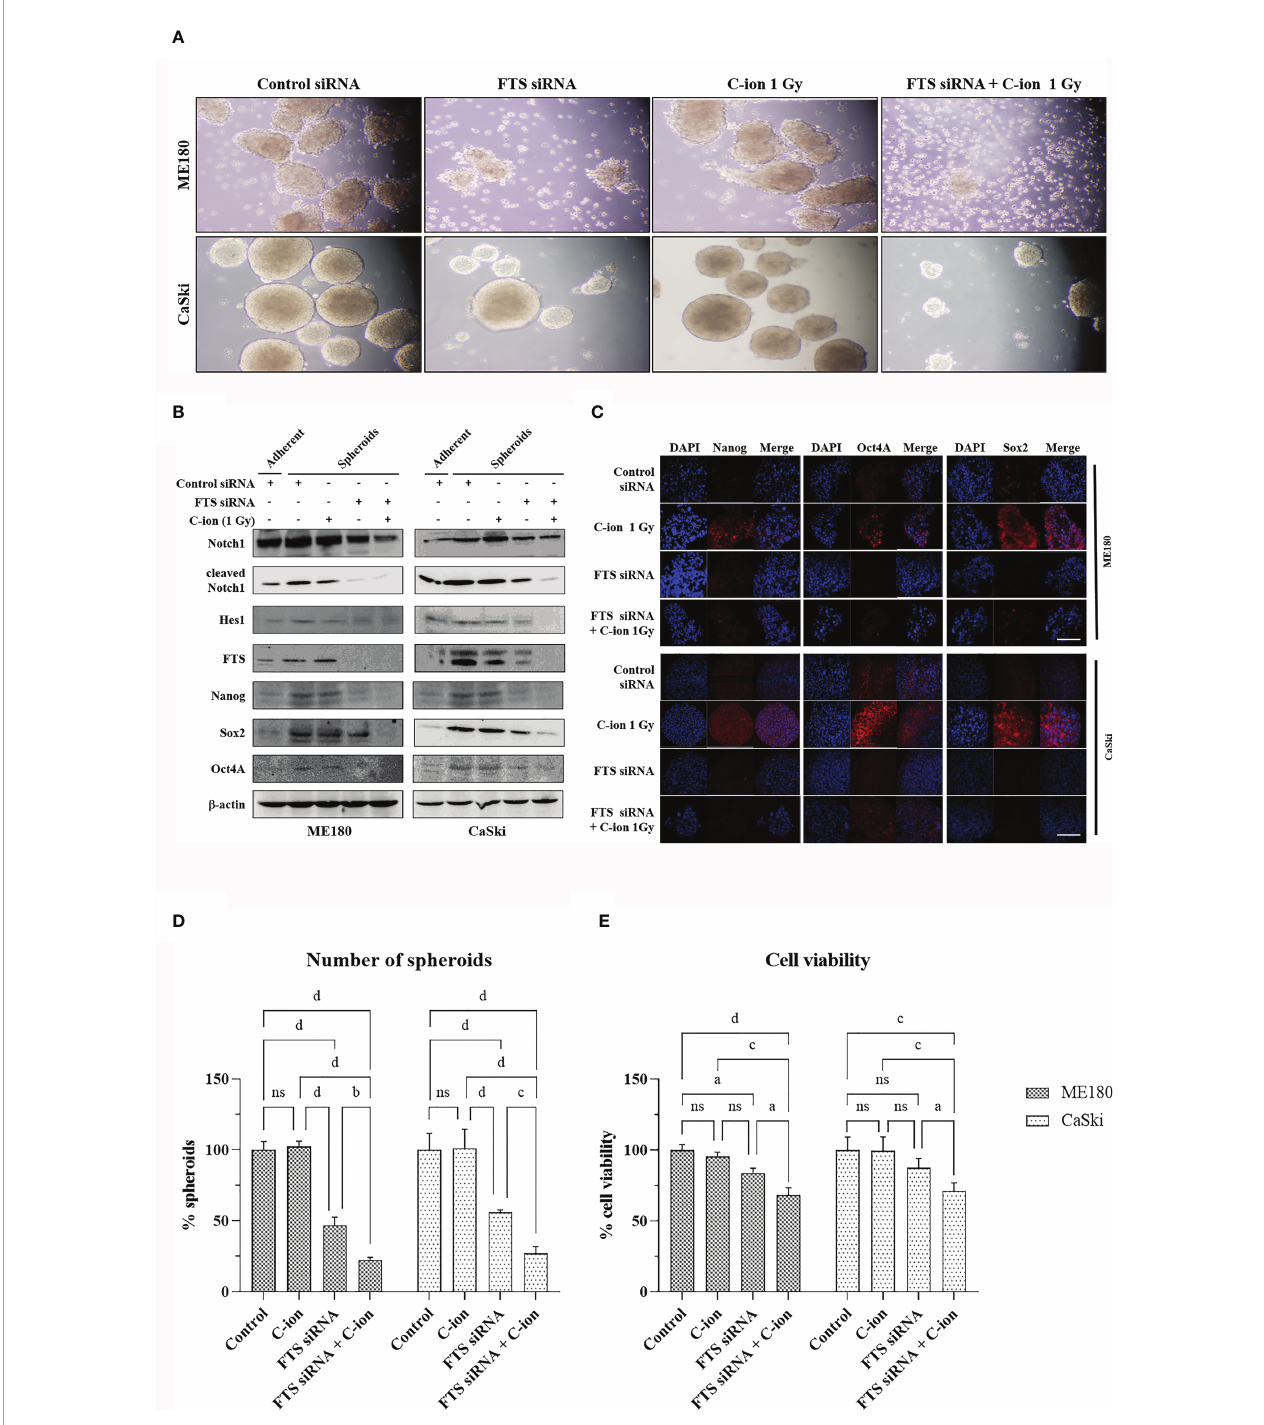
FIGURE 5 | FTS silencing combined with C-ion reduces spheroid formation and cancer stem cell markers in cervical cancer cells. FTS intact or silenced ME180 and CaSki cells were irradiated with 0 or 1 Gy of C-ion. Following irradiation, the cells were harvested and cultured in ultra-low attachment plates for seven days. Spheroid formation assay (A) . Western blots and immuno fl uorescence performed with the spheroids displaying the reduced expression of stem cell markers in the FTS silenced group (B, C) , white bar in each panel corresponds to 50 µm. (D) shows the mean number of spheroids from fi ve randomly selected fi elds under the microscope in each treatment group. Bars represent normalized values against control group, error bars represent ± SD. (E) shows the viability of the spheroid forming cells in each treatment group. Bars represent normalized values against control group, error bars represent ± SD. P values of < 0.05 were considered statistically signi fi cant. a p < 0.05; b p < 0.005; c p < 0.001; d p < 0.0001; ns, not signi fi